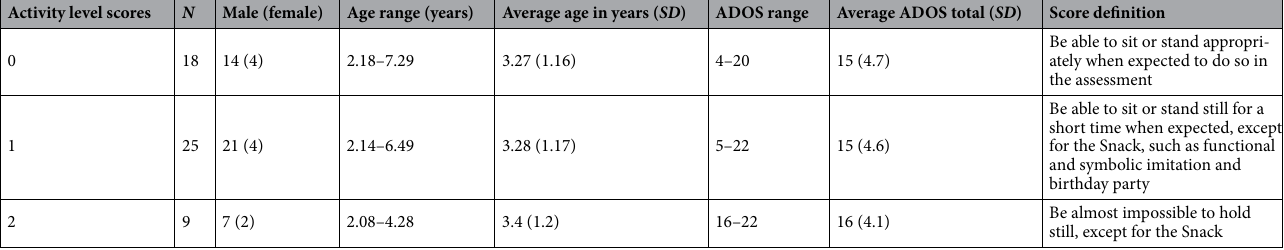
Table 1. Participants’ characters and score definition.